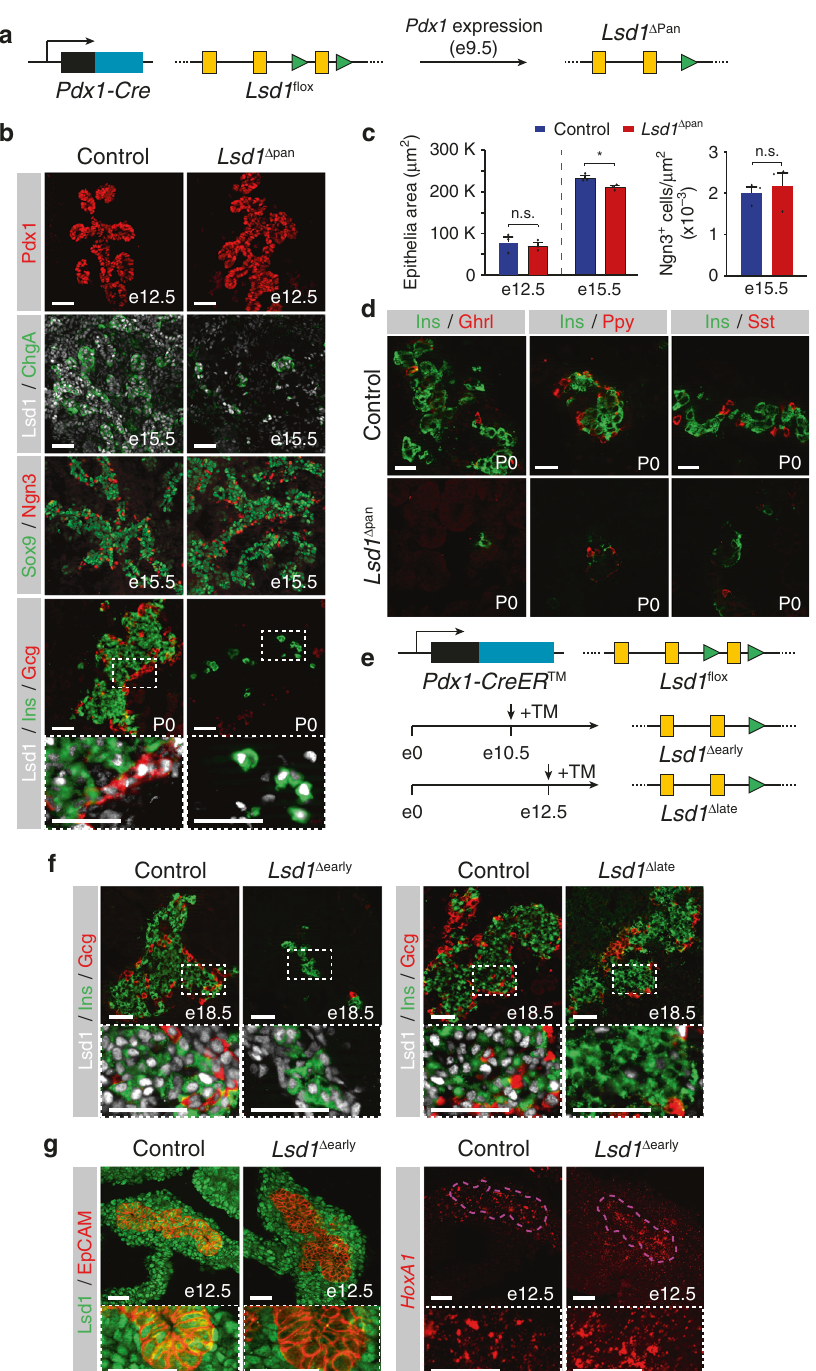
Fig. 6 Lsd1 is required for endocrine cell formation in mice during a short window in early pancreatic development. a Strategy for conditional Lsd1 deletion in embryonic pancreatic progenitors of mice ( Lsd1 Δ pan mice). Yellow boxes: exons; green triangles: loxP sites. b Immuno fl uorescent staining for Pdx1 at embryonic day (e) 12.5, Lsd1 and chromogranin A (ChgA) or Sox9 and Ngn3 at e15.5, and Lsd1, insulin (Ins) and glucagon (Gcg) at postnatal day (P) 0 in control and Lsd1 Δ pan mice (representative images, n = 6 embryos per genotype). Boxed areas are shown in higher magni fi cation. Scale bar, 50 µ m. c Quanti fi cation of pancreatic epithelial area at e12.5 and e15.5 and Ngn3 + cells relative to epithelial area. Data are shown as means ± S.E.M. ( n = 3 embryos per genotype; source data are provided as a Source Data fi le). P = 0.65, 0.02, and 0.39, respectively, Student ’ s t-test, 2 sided. d Immuno fl uorescent staining for Ins with somatostatin (Sst), pancreatic polypeptide (Ppy) and ghrelin (Ghrl) at P0 in control and Lsd1 Δ pan mice. Scale bar, 25 µ m. e Strategy for tamoxifen-inducible Lsd1 deletion in embryonic pancreatic progenitors of mice at e10.5 ( Lsd1 Δ early ) and e12.5 ( Lsd1 Δ late ). Yellow boxes: exons; green triangles: loxP sites. f Immuno fl uorescent staining for Lsd1, Ins and Gcg at e18.5 in control, Lsd1 Δ early and Lsd1 Δ late mice (representative images, n = 3 embryos per genotype). Boxed areas are shown in higher magni fi cation. Scale bar, 50 µ m. g Immuno fl uorescent staining for Lsd1 and EpCAM (left panels) and RNAscope in situ hybridization for HoxA1 (right panels, adjacent sections to left panels) in control and Lsd1 Δ early embryos at e12.5 (representative images, n = 3 Lsd1 Δ early embryos and n = 6 control embryos). Bottom images show higher magni fi cation. Scale bar, 50 µ